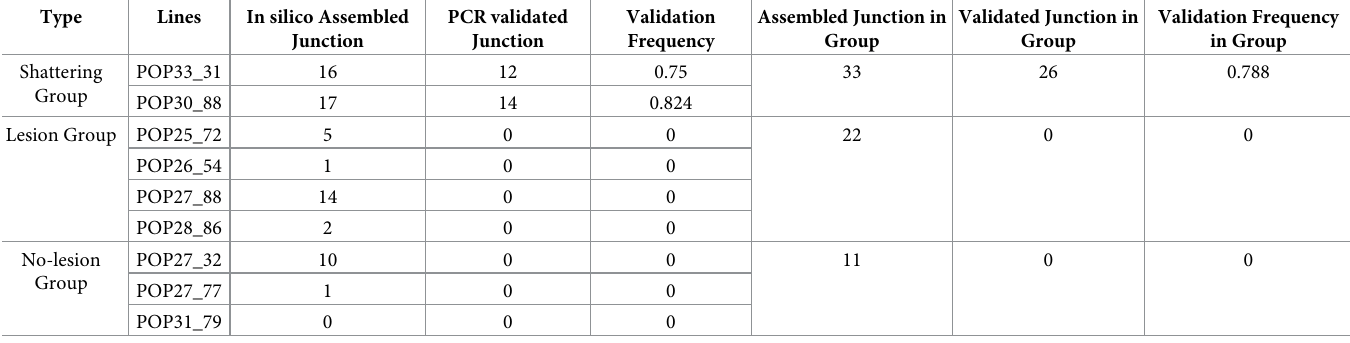
Table 1. Summary of DNA junction validation frequencies.